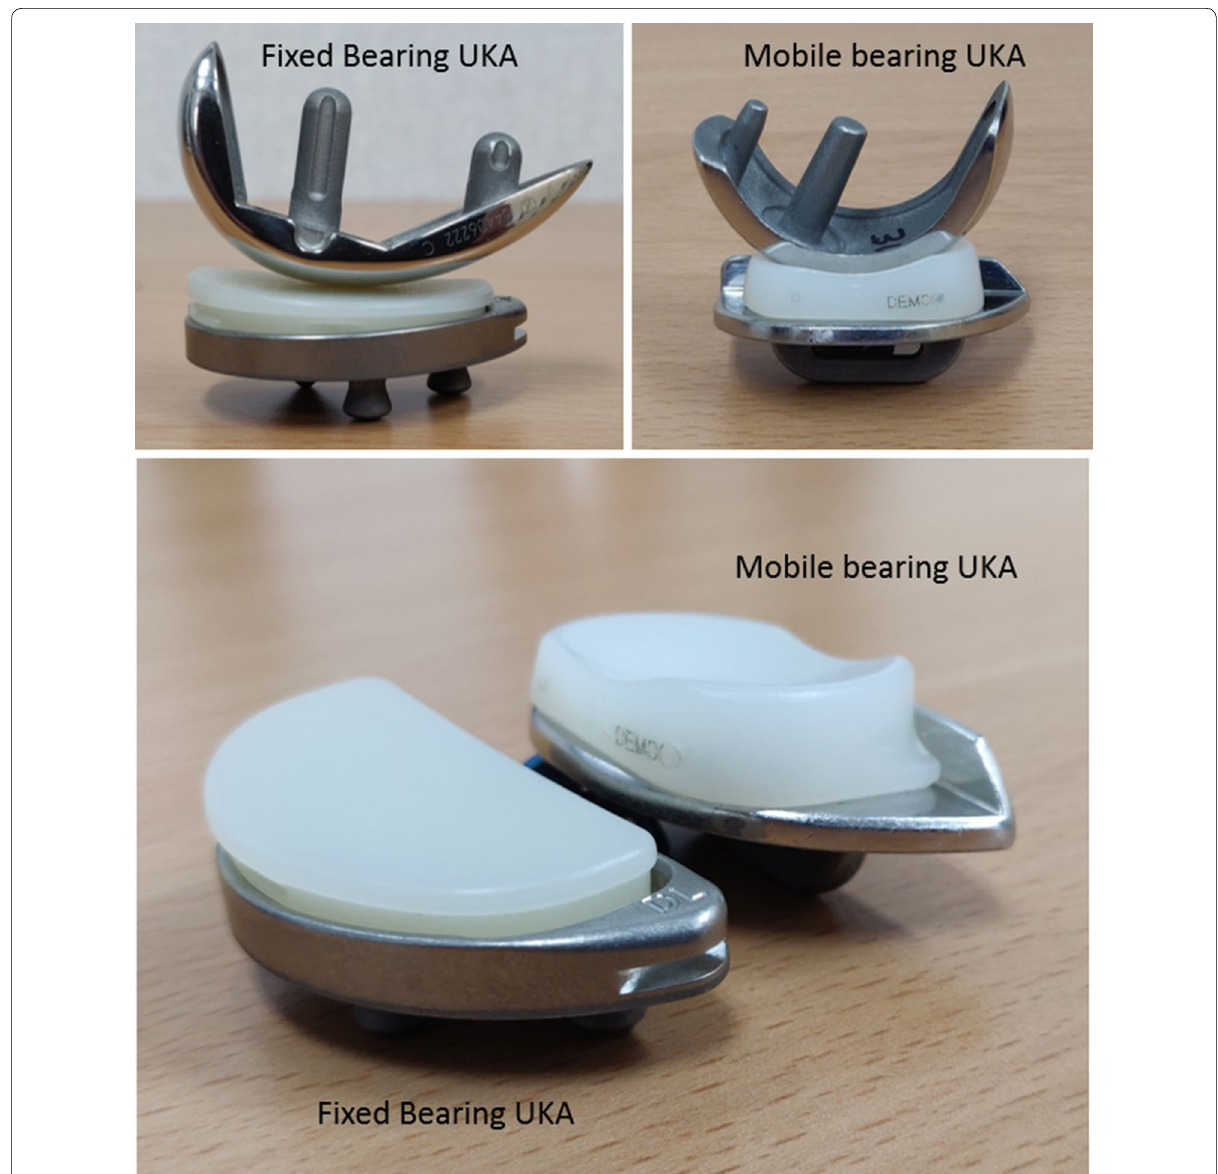
Fig. 2 Fixed bearing UKA: noncongruous articular surface, small contact area, large point contact force, and ‘insert’ fixed to base plate. Mobile bearing UKA: congruous articular surface, large contact area, small point contact force, and mobile